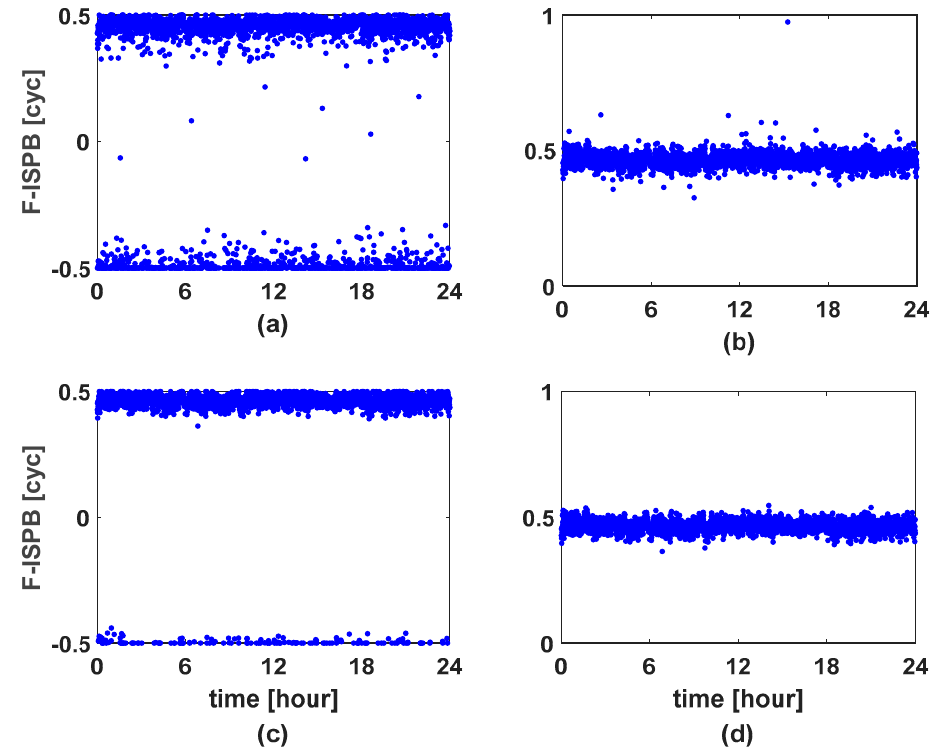
Figure 4. F-ISPB estimation results of CUTB–CUT0 baseline. ( a ) Standard PSO. ( b ) PSO for adaptive search space. ( c ) PSO for elite retention strategy. ( d ) Improved PSO with both functions. All epochal ratio values of CUTB–CUT0 baseline obtained by using the inter-system